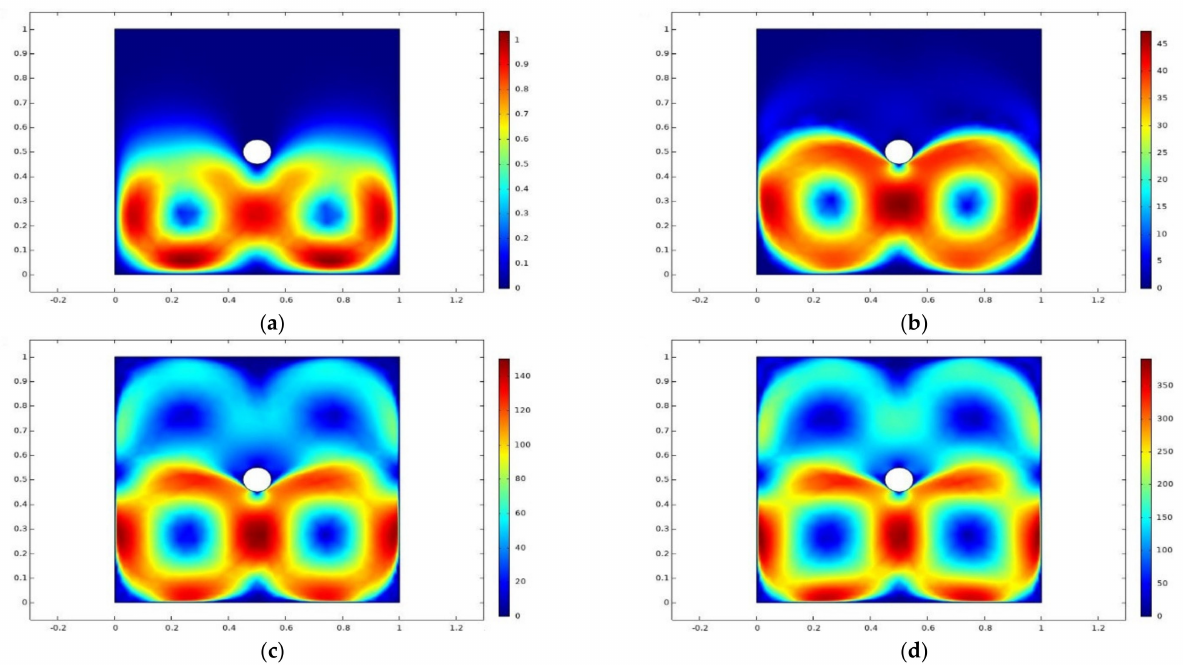
Figure 5. Impact of Rayleigh number ( Ra ) on velocity distribution, ( a ) ( Ra = 100), ( b ) ( Ra = 10 3 ), ( c ) ( Ra = 10 4 ), ( d ) ( Ra = 10 5